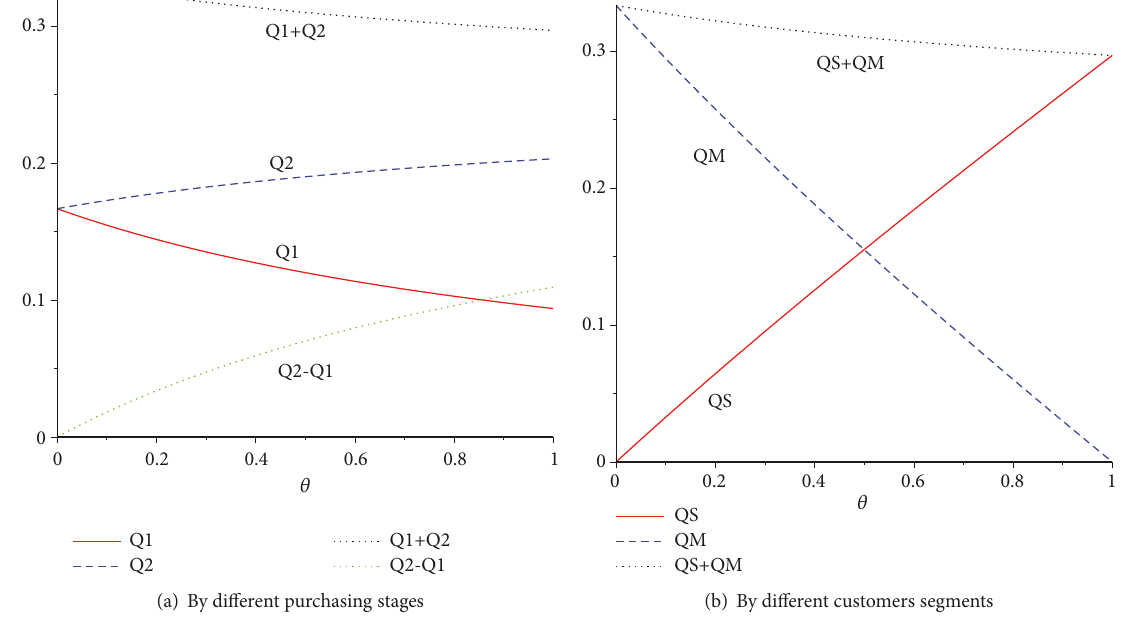
Figure 4: Impact of the proportion of strategic consumer 𝜃 on demand